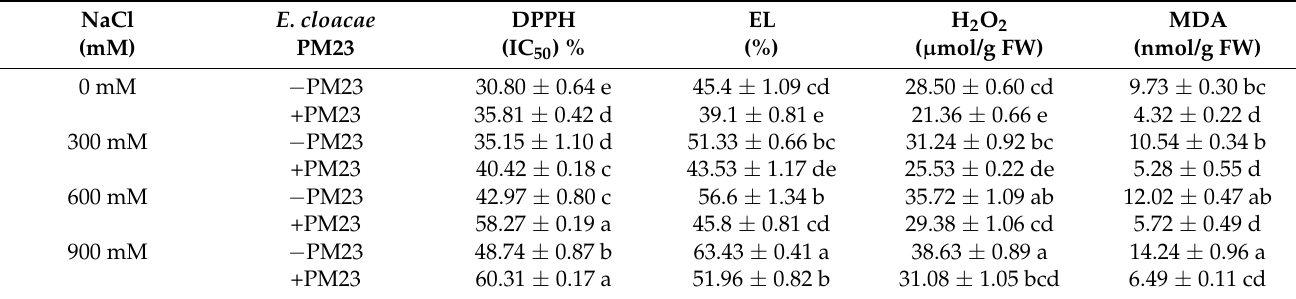
dissimilar letters within rows that represent significance ( p ≤ 0.05) level. Table 4. Level of oxidative stress markers in presence and absence of E. cloacae PM23 under salinity